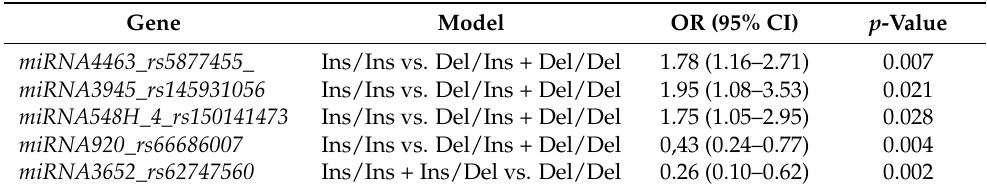
Table 4. Allelic variants in MIRNAs with significant associations for GC predisposition. Logistic regression analysis with Bonferroni